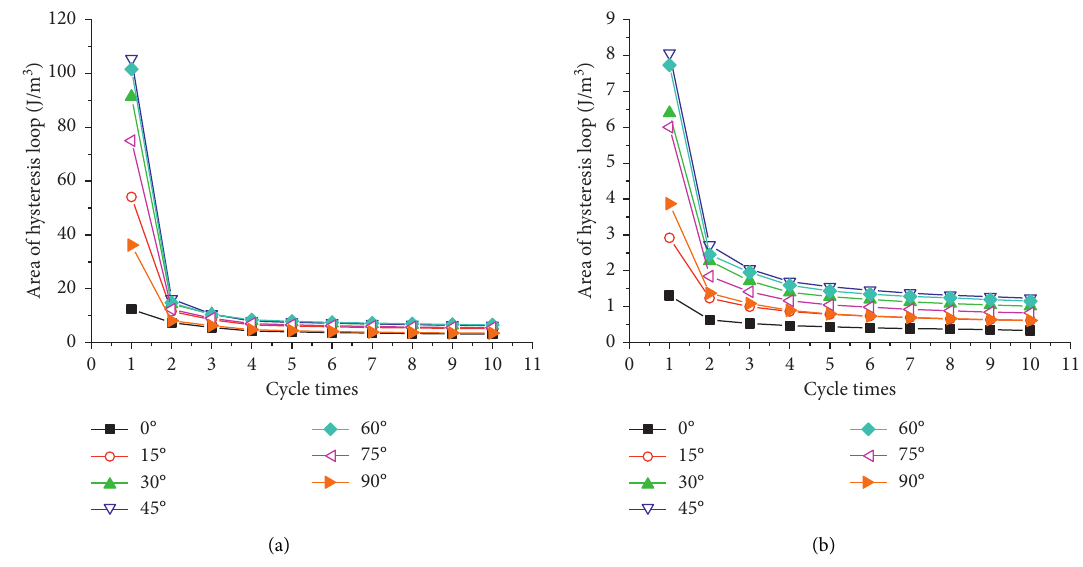
Figure 19: Relationship between the area of hysteresis loop and cyclic times. (a) PVC membrane material. (b) PV-PVC